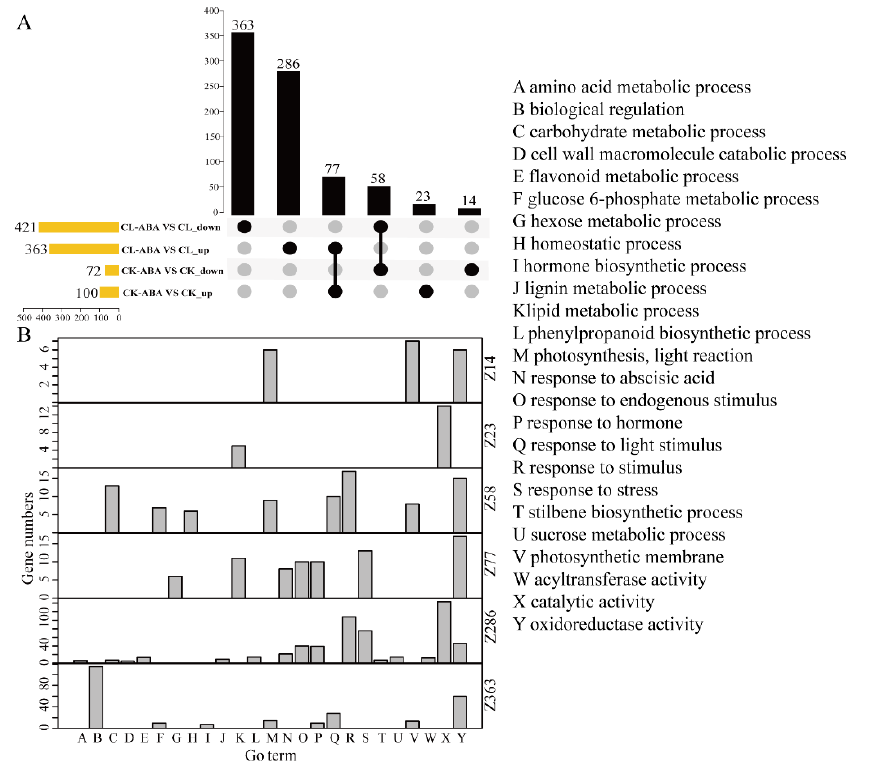
Figure 4. The number and functional enrichment of genes in different combinations under ABA treatment with different carbon supplies. ( A ) The number of DEGs between different combinations. The overlap of DEGs in different combinations were visualized with UpSetR. The vertical bars represent the number of DEGs within each intersect, while the filled circles below show the combinations for established intersect. Two connected circles indicate that these DEGs are present in both combinations. The horizontal bars represent the total number of DEGs for each combination. ( B ) The number of the selection of significant enrichment terms from GO enrichment analysis for the DEGs in different zones. The six different combinations are named Z (zones), with the DEG counts of different zones found on the right-axis labels in ( B ), and the different GO terms are represented by capital